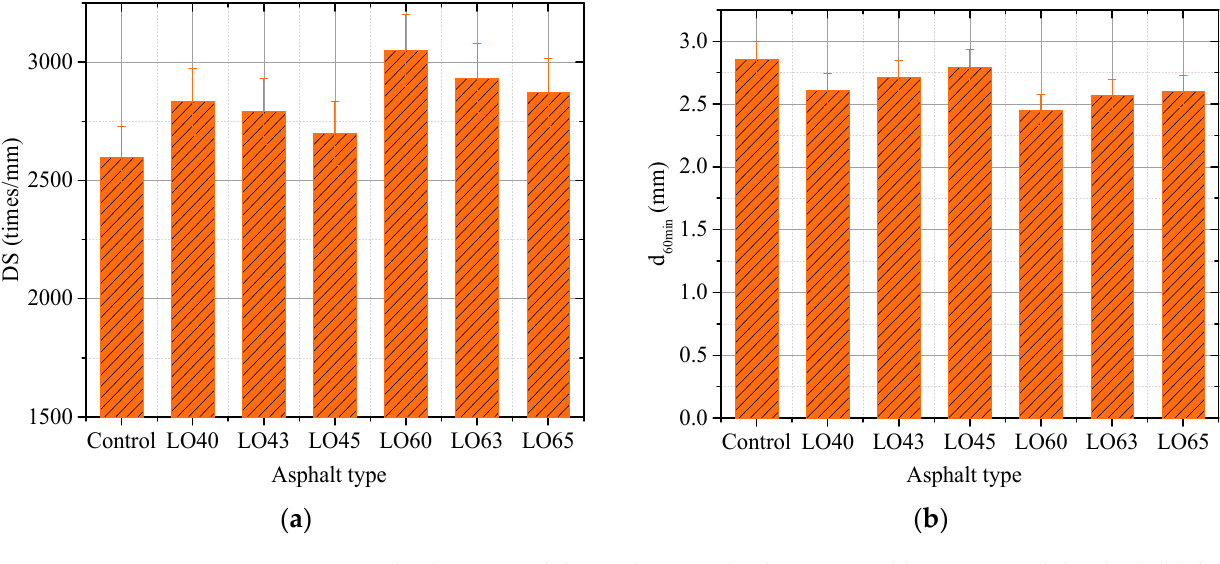
Figure 8. The dynamic stability and rutting depth at 60 min. ( a ) Dynamic stability (DS); ( b ) d 60min